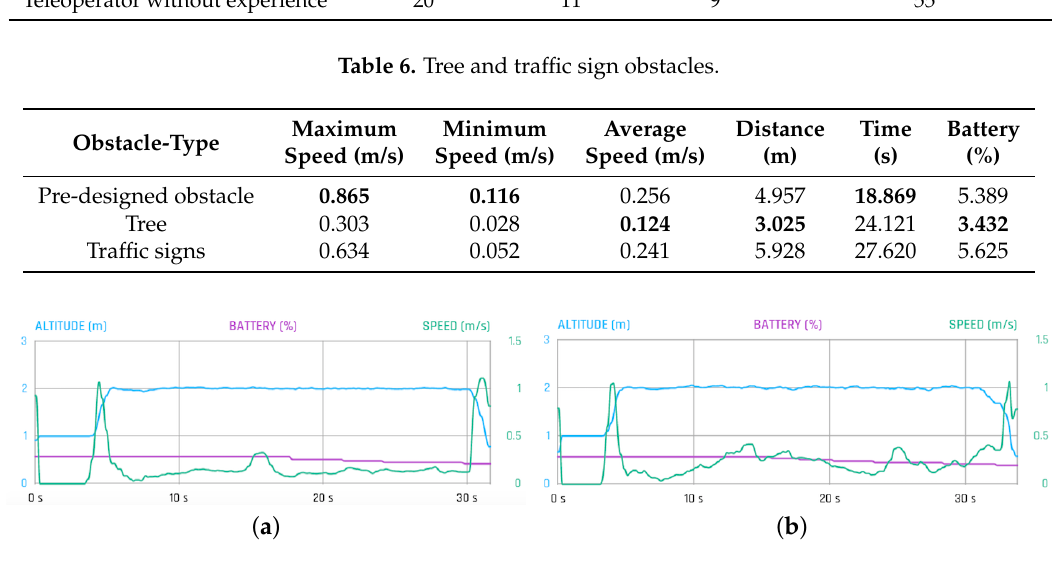
Figure 26. Results of one tree and two traffic signs as obstacles. ( a ) One tree; ( b ) two traffic signs. Table 7. Results of flights with tree and traffic sign